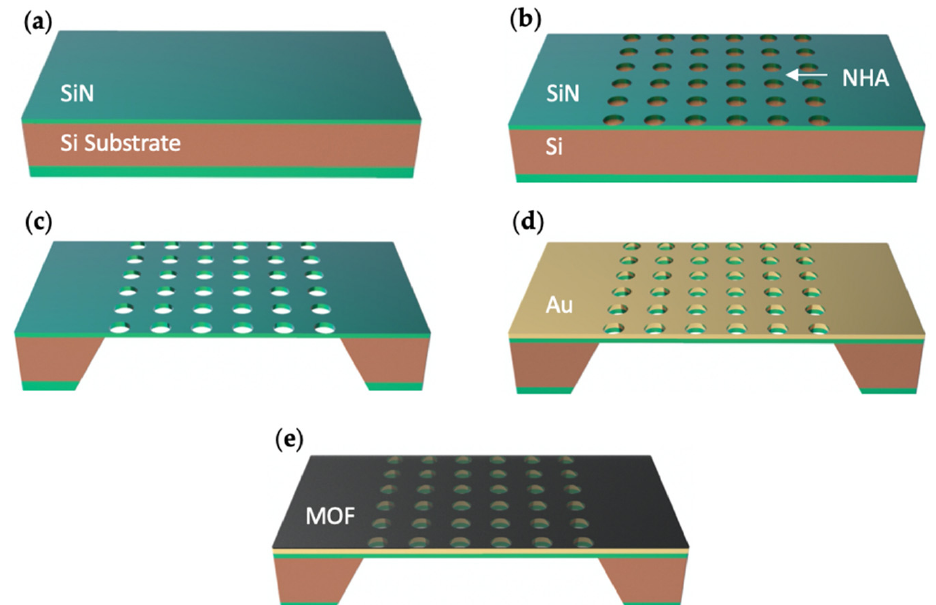
Figure 1. Schematic of nanohole array fabrication. Fabrication steps include: ( a ) LPCVD depositing silicon nitride layer; ( b ) EBL and RIE patterning NHA structures; ( c ) Mask aligner and RIE patterning membrane window; KOH wet etching silicon to create silicon nitride membrane; ( d ) E-beam evaporator depositing Ti/Au layer; ( e ) Coating Cu-BTC MOF layer.